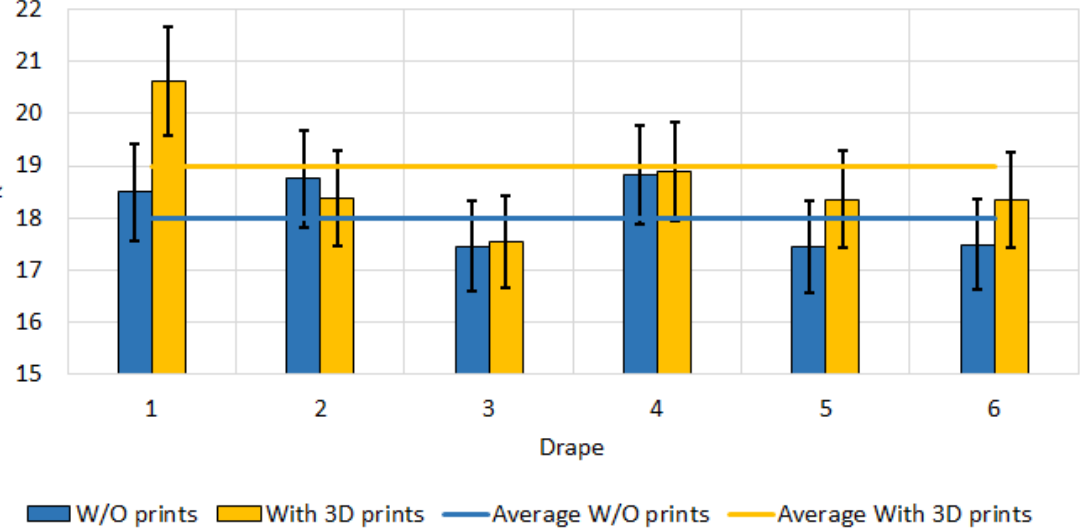
Figure 13. Changes in coefficient of form K. The values are significantly different at p < 0.05.